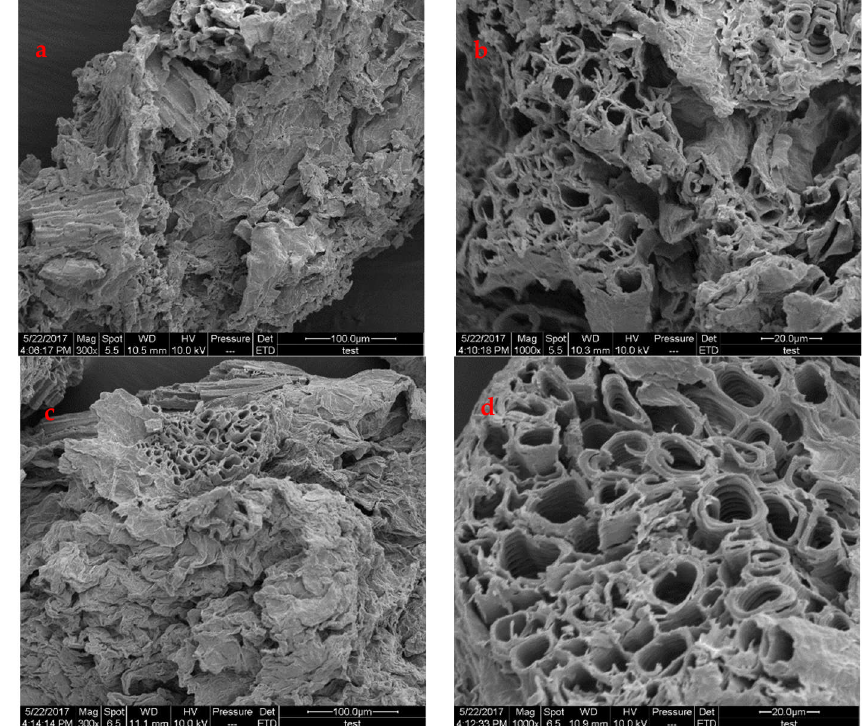
Figure 2. Surface morphology of the PPL ( a , b ) and MPPL ( c , d ).